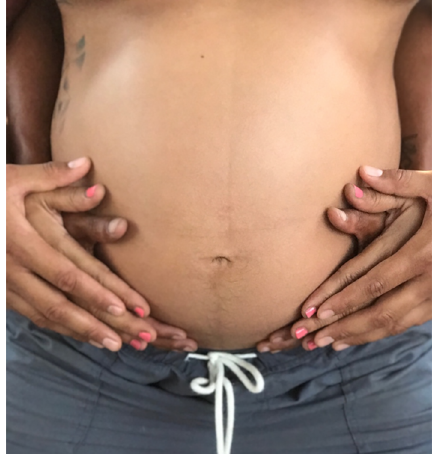
Figure 1. Alex, Organizer and What’s Your Issue?